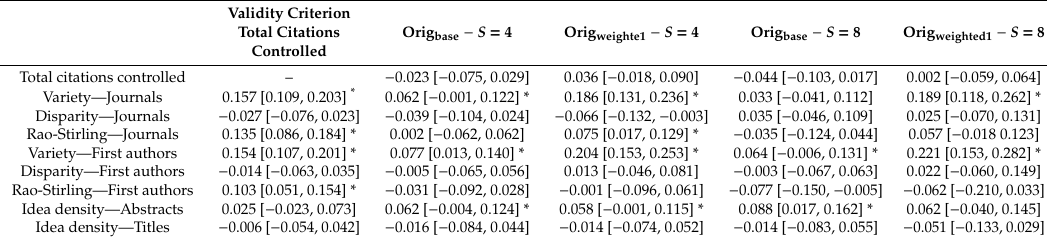
Table 2. Validity findings for the creativity dataset.